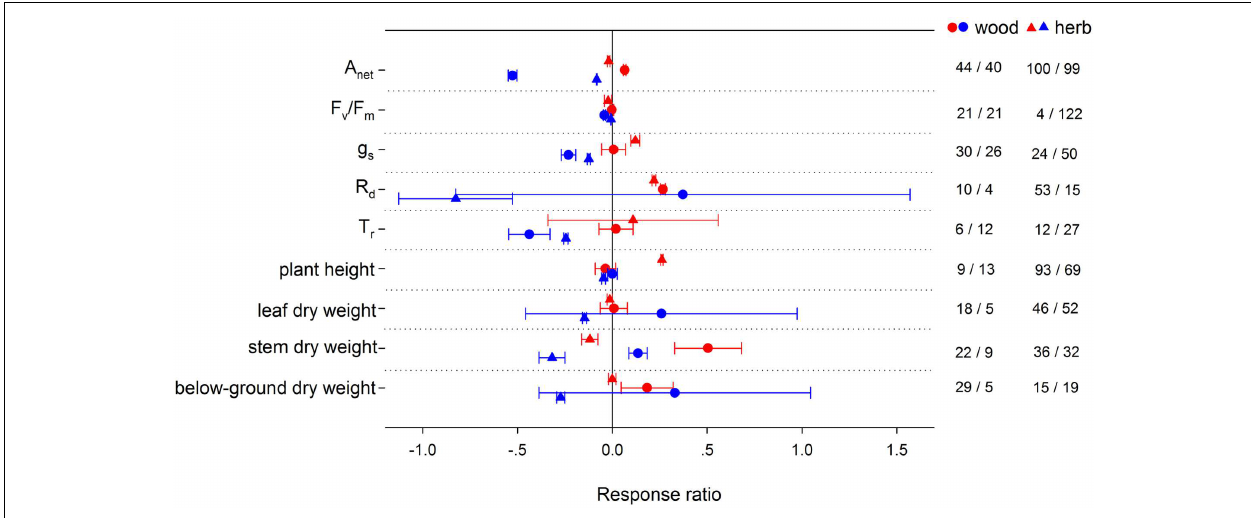
FIGURE 3 | Plant physiological, morphological and yield-related responses to HNT (red) and LNT (blue) in woody (circles) and herbaceous (triangles) species. Each data point represents the mean ± 95% CI. The number of observations for each variable is given on the right of the graph.